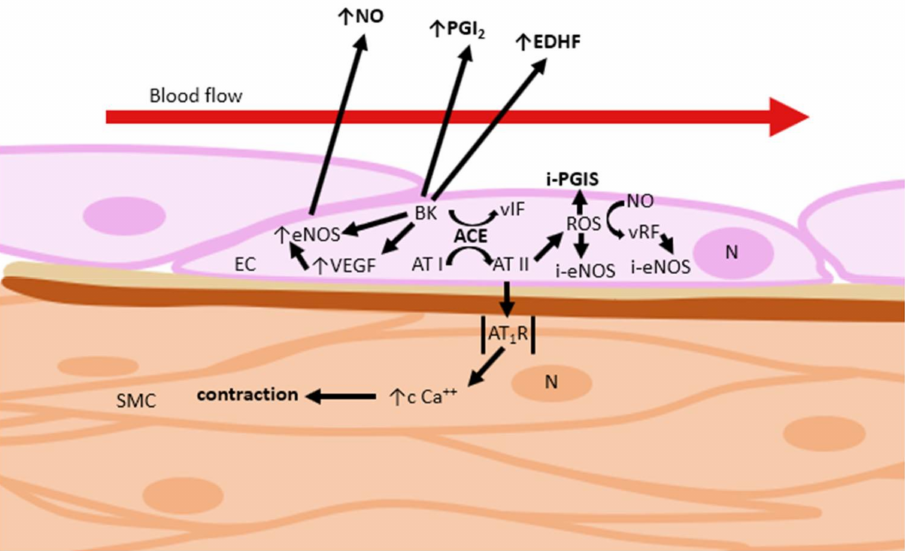
Figure 4. Regulation of vascular tone via ACE pathway. AT I: angiotensin I; AT II: angiotensin II; ACE: angiotensin-converting enzyme; AT 1 R: angiotensin type-1 receptor; BK: bradykinin; EC: endothelial cell; eNOS: endothelial NO synthase; i-eNOS: endothelial NO synthase inhibition; i-PGIS: prostacyclin synthase inhibition; NO: nitric oxide; N: nucleus; ROS: reactive oxygen species; SMC: smooth muscle cell; vIF: various inactive fragments; vRF: various reactive